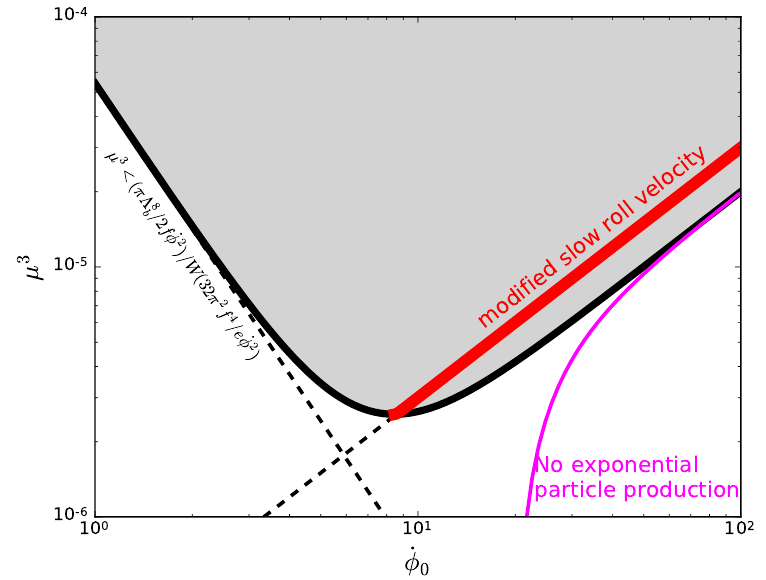
Figure 7 . Same as (cid:12)gure 6. The decay constant and Hubble expansion rate are (cid:12)xed to f= (cid:3) b = 10 3 , H= (cid:3) b = 10 (cid:0) 7